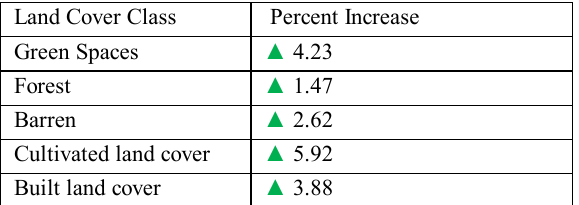
Table 2. Percent Increase in LST from 2001 through